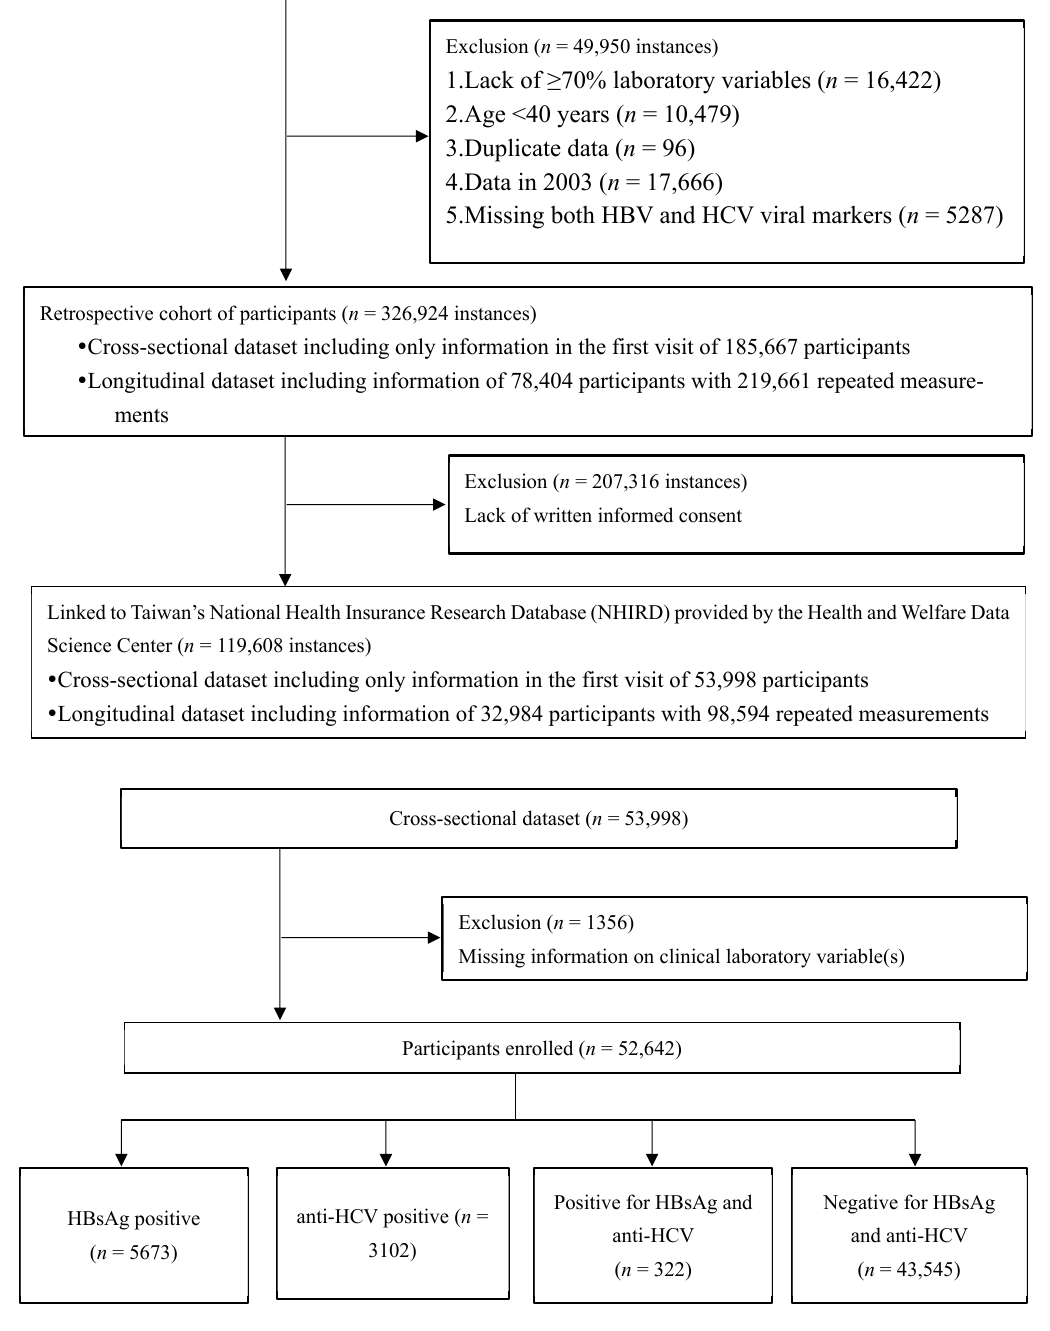
Figure 1. Flow diagram showing the disposition of participants in the